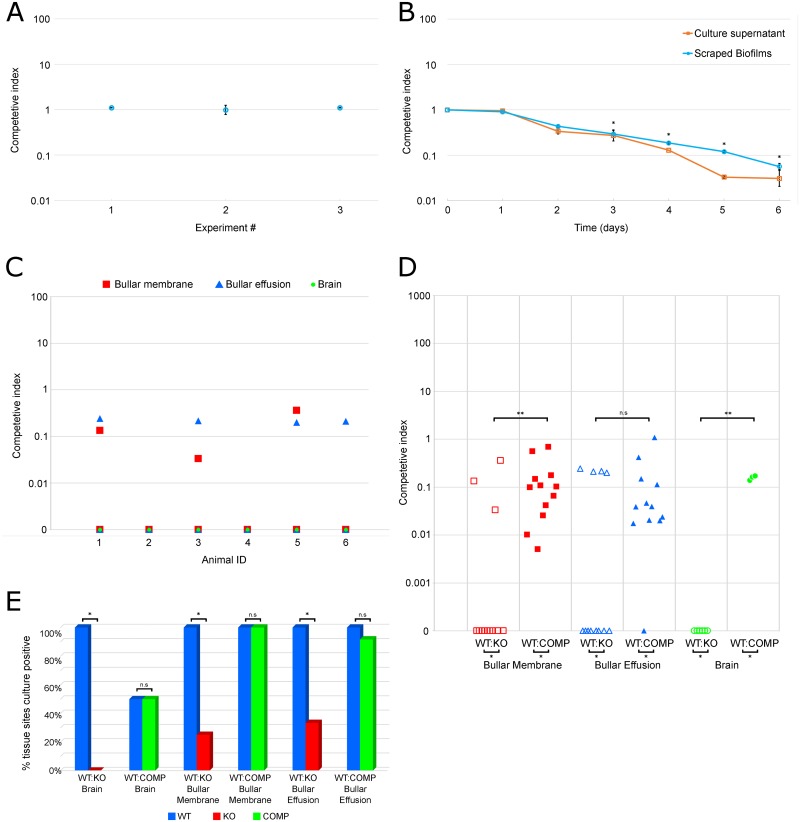
PittII Msf-KO strain suffers a large competitive disadvantage compared to WT.Competitive Index (CI) refers to a ratio of mutant bacteria to WT bacteria adjusted for the initial inoculum ratio. CI of 1 indicates no competitive advantage. Data points below 1 indicate a WT advantage and data points above 1 indicate a mutant advantage (A-D). (A) PittII WT and Msf-KO inoculated 1:1 in planktonic culture for 24 hours (3 experiments with n = 3, error bars denote the standard deviation of each experiment). (B) PittII WT and Msf-KO inoculated 1:1 in biofilm culture harvested over a 6 day period (3 experiments with n = 3, error bars denote the standard error of the mean). CFU were enumerated from both the adherent biofilms as well as the overlying supernatant and the CI was determined from each fraction. *p<0.05 by one-sample two-tailed t-test (μ0 = 0) on the log CI for both the biofilm and planktonic fractions. (C-E) In two separate experiments six chinchillas were inoculated with 1:1 mixtures of strains and five tissue sites (brain, right and left bullar membranes and right and left bullar effusions) were harvested three days after inoculation. Thus n = 6 for brains and n = 12 for bullar sites. (C)
In vivo competition between PittII WT and Msf-KO inoculated 1:1 into 6 animals. Each data point represents a single tissue-site CI value. Points on the X-axis (CI of 0) indicate that no KO bacteria were observed and therefore have an infinitely low CI value. (D)
In vivo competition between PittII WT and Msf-COMP inoculated 1:1 into 6 animals compared with the previous data obtained from competition between PittII WT and Msf-KO in vivo. Each data point represents a single tissue-site CI value. Points on the X-axis (CI of 0) indicate that no KO bacteria were observed and thus have an infinitely low CI value. *p<0.05 by two-tailed t-test for two independent means of log cfu data. **p<0.05 by Mann-Whitney U test. n.s. (not significant). (E) Percentage of tissue sites that were positive for bacteria in each of the two in vivo competition experiments (WT vs Msf-KO, and WT vs Msf-COMP). * p<0.05 by two-tailed Fisher-exact test. n.s. (not significant).